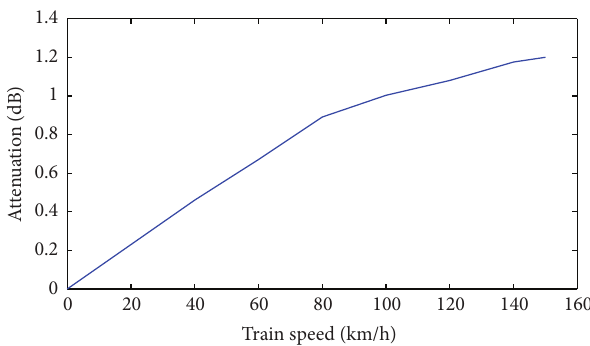
Figure 15: Attenuation measurement under different train speeds.